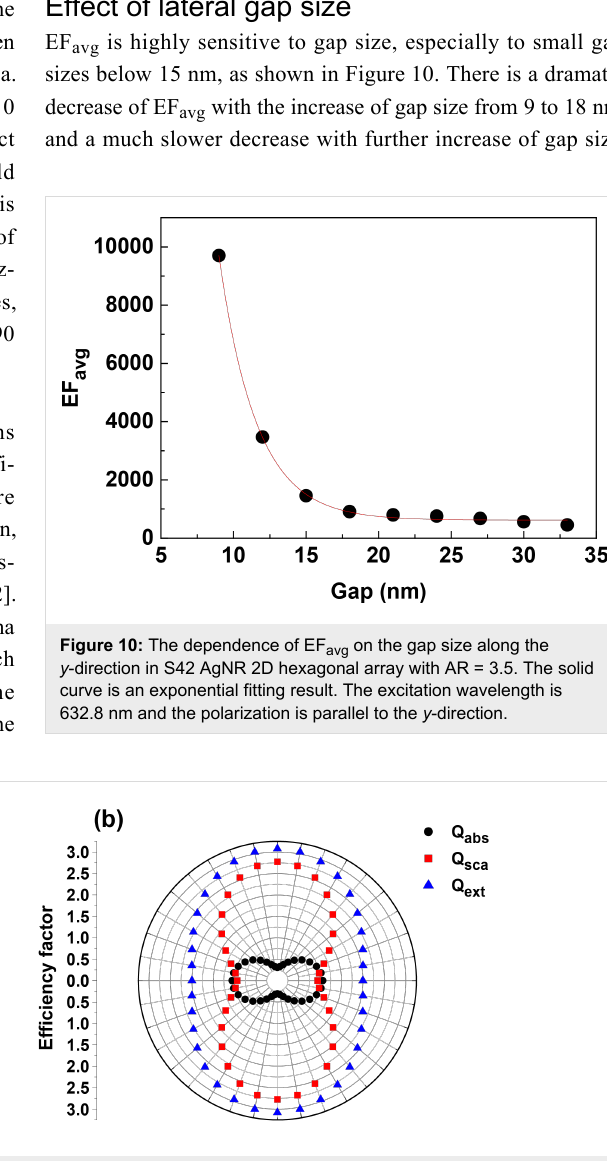
Figure 9: The polarization-dependent EF avg (a) and the corresponding absorption (black), scattering (red) and extinction (blue) efficiency factors (b) of S42 AgNR 2D hexagonal array with AR = 3.5. The excitation wavelength is 632.8 nm.